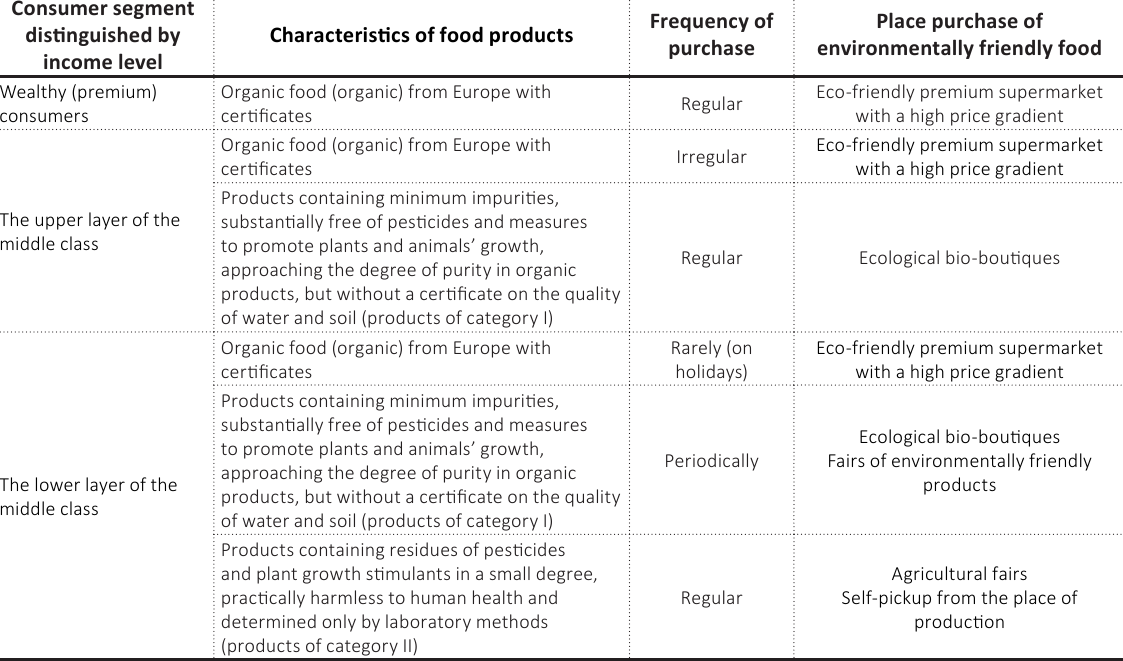
Source: Developed by the